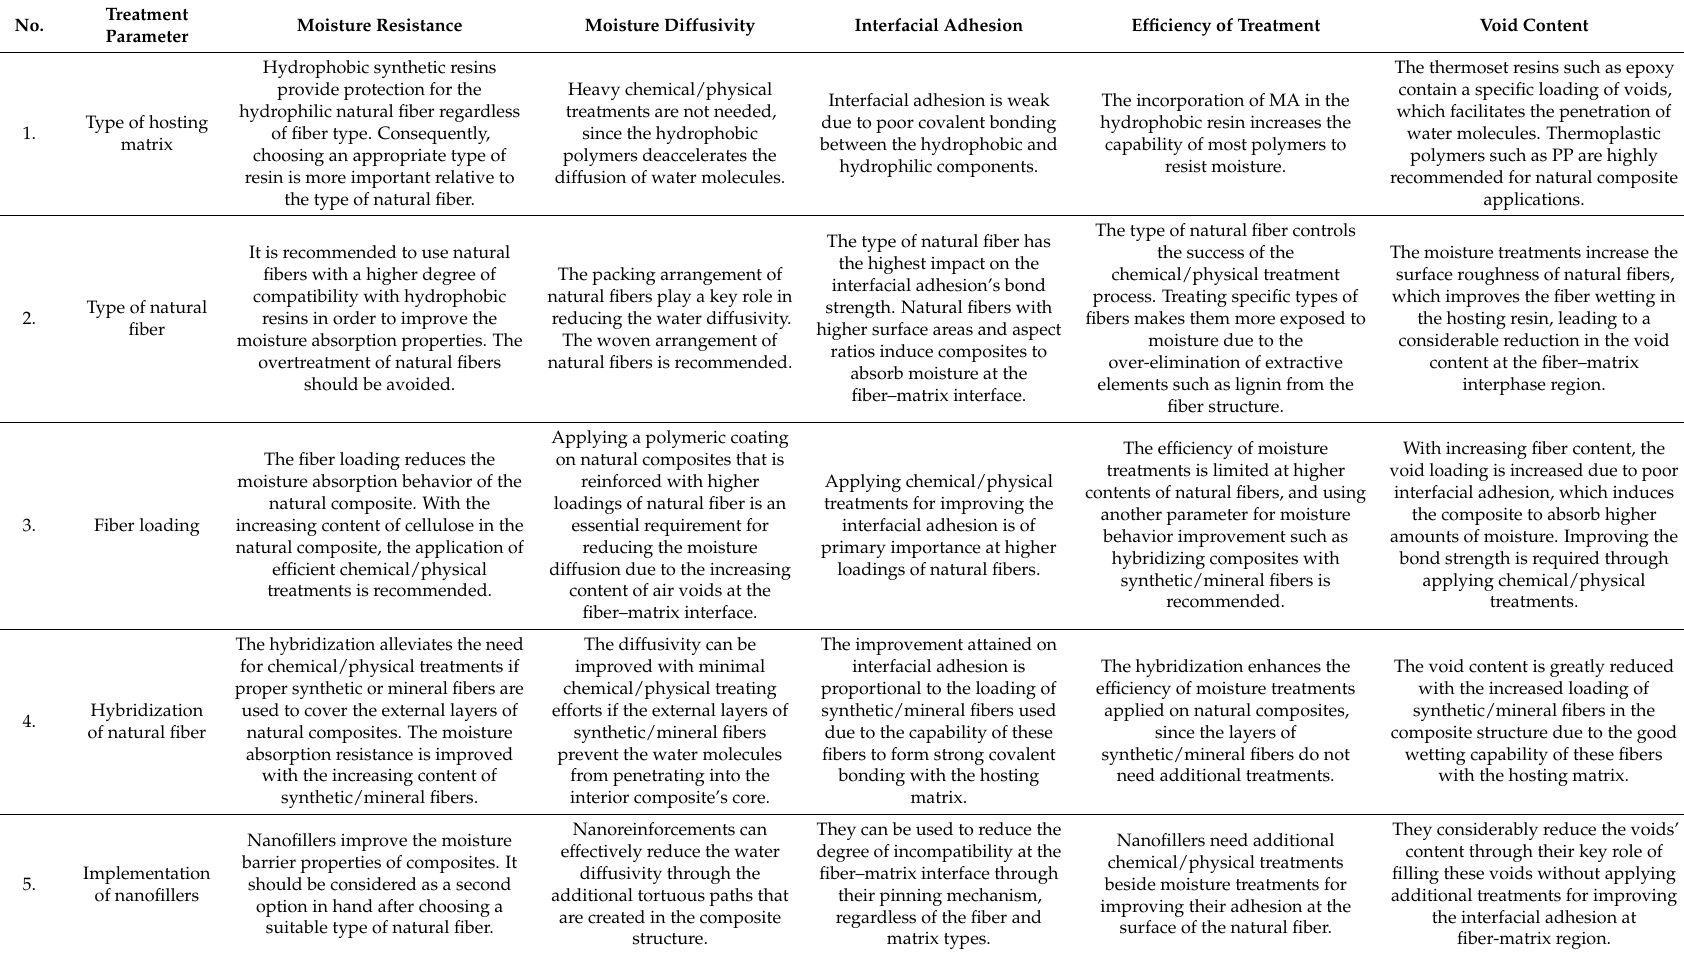
Table 4. Comparison between moisture treatment parameters of natural